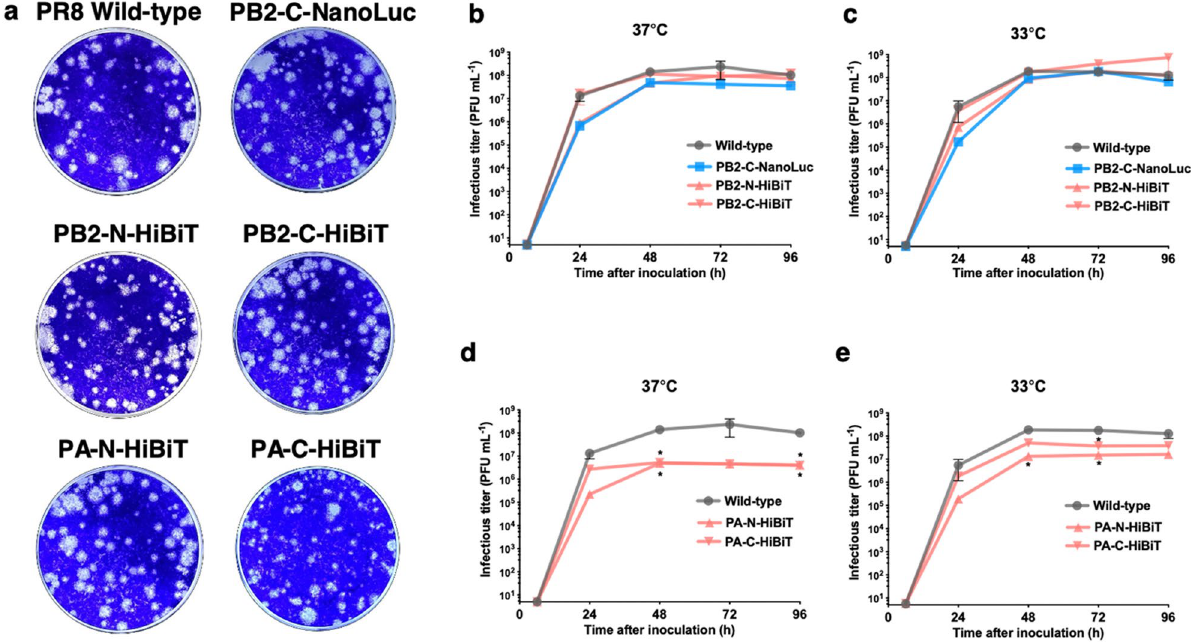
Figure 2. Growth kinetics of bioluminescent IAVs in MDCK cells. ( a ) Plaque formation of bioluminescent IAVs in MDCK cells. We compared plaque formation from bioluminescent IAVs at 4 days post inoculation. Confluent MDCK cells in 12-well plates were infected with IAVs (MOI, 0.0002), and plaques were stained with crystal violet, and imaged. PB2-C-NanoLuc and all HiBiT IAVs formed plaques like wild-type PR8 IAV, indicating that the NanoLuc or HiBiT tags did not hinder plaque formation of bioluminescent IAVs. ( b,c ) Multi-step growth curves of PB2-C-NanoLuc (blue), PB2-N-HiBiT and PB2-C-HiBiT (pink), and wild-type PR8 IAVs (gray) at low multiplicity of infection (MOI, 0.001). ( b ) At 37 °C, all PB2 bioluminescent IAVs replicated productively, like wild-type PR8 IAV. ( c ) At 33 °C, all PB2 bioluminescent IAVs replicated productively, like wild-type PR8 IAV. ( d,e ) Multi-step growth kinetics of PA-N-HiBiT and PA-C-HiBiT (pink) and wild-type PR8 IAVs (gray) at low MOI (0.001). ( d ) At 37 °C, PA-N-HiBiT and PA-C-HiBiT replication were significantly less than wild-type IAV. * p < 0.05. ( e ) At 33 °C, PA-N-HiBiT and PA-C-HiBiT replication were significantly less than wild-type IAV. Data represent the mean ± SEM of results determined in 3 independent experiments, each performed in triplicate. The limit of detection was 10 PFU mL −1 . * p <